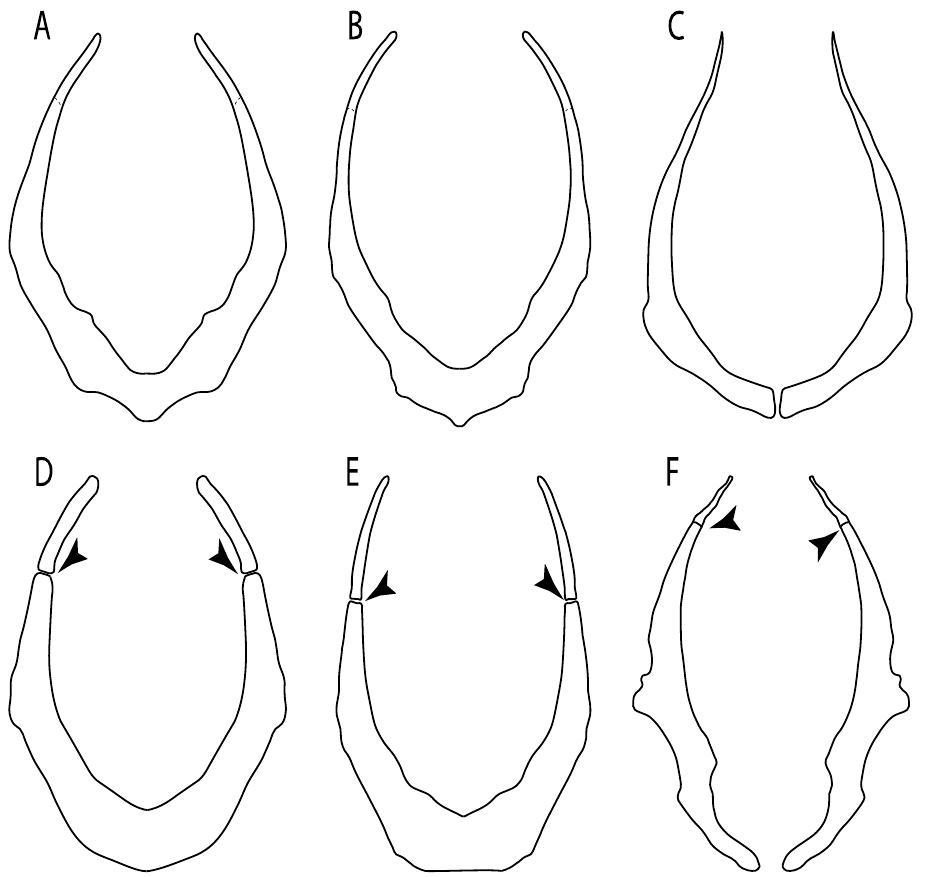
Figure 34. Interpretative drawings of the pectoral girdle in frontal view. State (0): ( A ) Squalus acanthias (HUMZ 30291) redrawn and modified from da Silva and de Carvalho Text-Figure 33C in [8]; ( B ) Squalus megalops (MZUSP 110973) redrawn and modified from da Silva and de Carvalho Text-Figure 25D in [8]; ( C ) Hexanchus griseus (CAS uncatalogued) redrawn and modified from da Silva and de Carvalho Text-Figure 32E in [8]. State (1): ( D ) Squalus brevirostris (AMNH 258171, https://sharksrays.org/ (accessed on 23 March 2020)); ( E ) Squalus mitsukurii (https://sharksrays.org/ (accessed on 23 March 2020)); ( F ) Chlamydoselachus anguineus (MZUSP 110974) redrawn and modified from da Silva and de Carvalho Text-Figure 26E in [8]. Arrowheads: articular surface between the scapula and the scapular process.